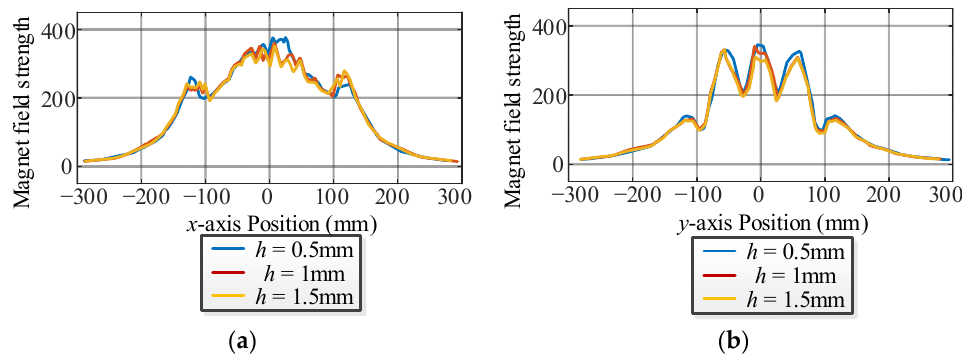
Figure 14. Magnet field strength waveforms with different heights. ( a ) x ‐ axis. ( b ) y ‐ axis.